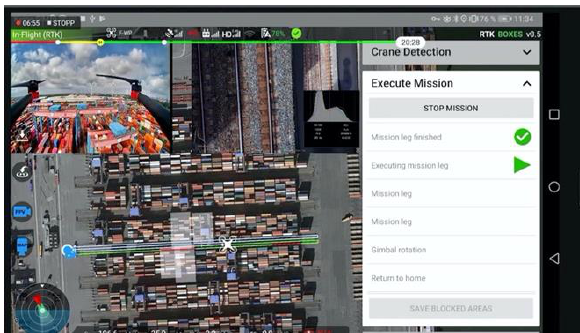
Fig. 5: Execution of the mission using the self-developed ground station app "Inspekt GS